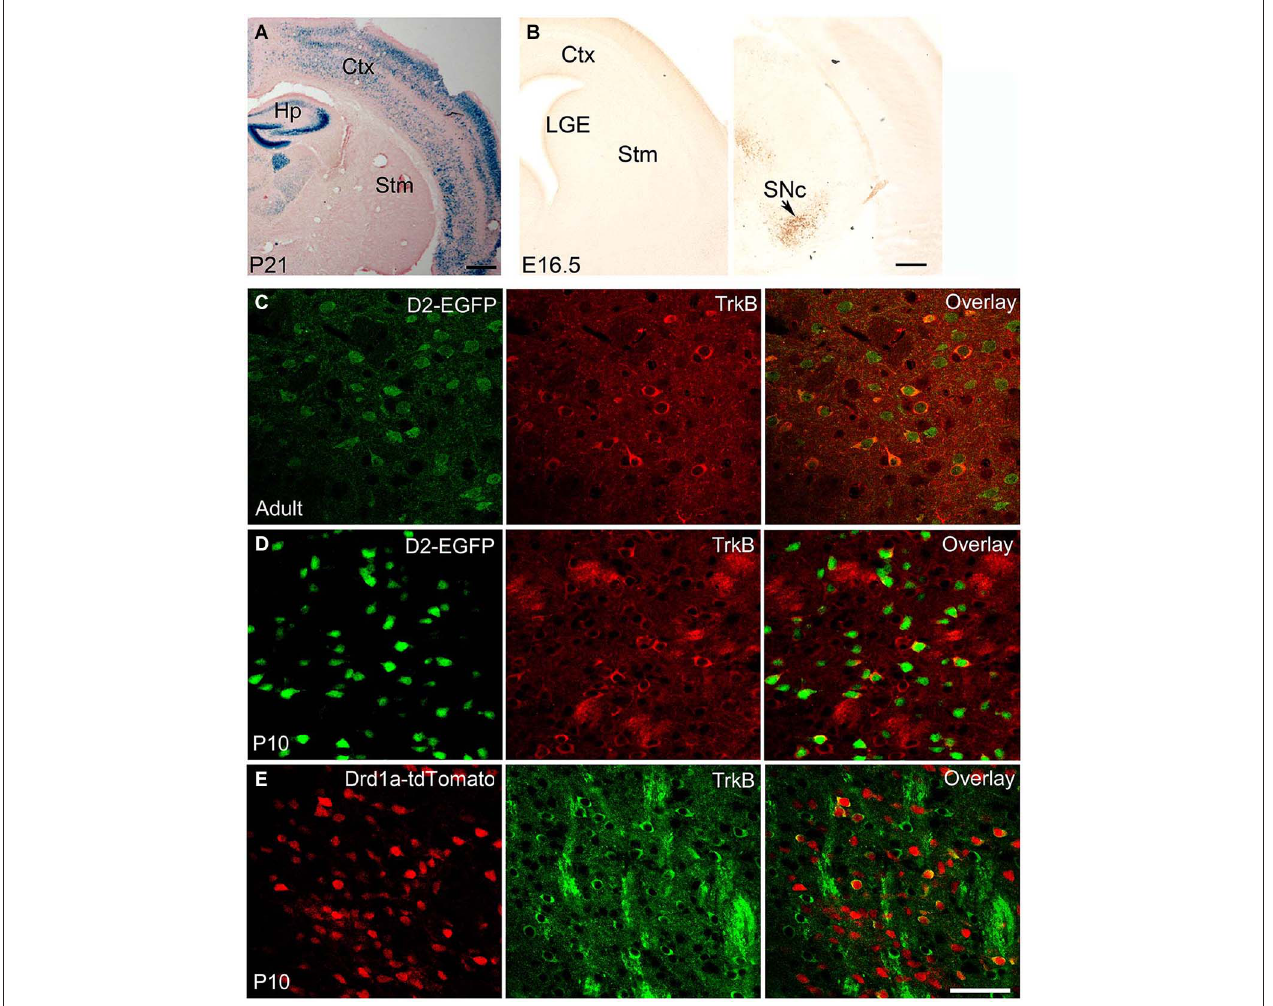
β -galactosidase and EGFP shows that the majority of TrkB-expressing neurons also express DRD2 in the adult striatum. (D) High co-expression of TrkB and DRD2 in the young striatum. Nearly all EGFP + cells expressed β -galactosidase in the striatum of TrkB LacZ/+ ; D2-EGFP mice at P10. (E) Low co-expression of TrkB and DRD1a in the striatum of TrkB LacZ/+ ; Drd1a-tdTomato mice at P10. Scale bar, 50 µ m. Ctx, cerebral cortex; Hp, hippocampus; LGE, lateral ganglionic eminence; SNc, substantia nigra pars compacta; Stm, striatum. This figure is adapted from Baydyuk et al. (2011,